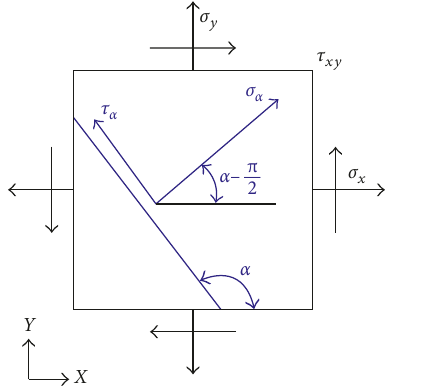
Figure 11: The normal and shear stresses on one plane through the midpoint of each line segment and the orientation of line segment.